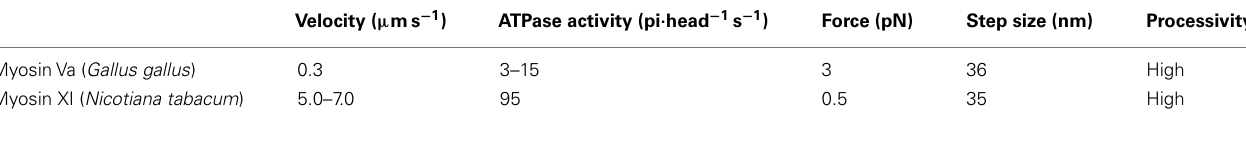
Table 1 | Comparison of molecular properties of myosinVa and Nt 175-kDa myosin